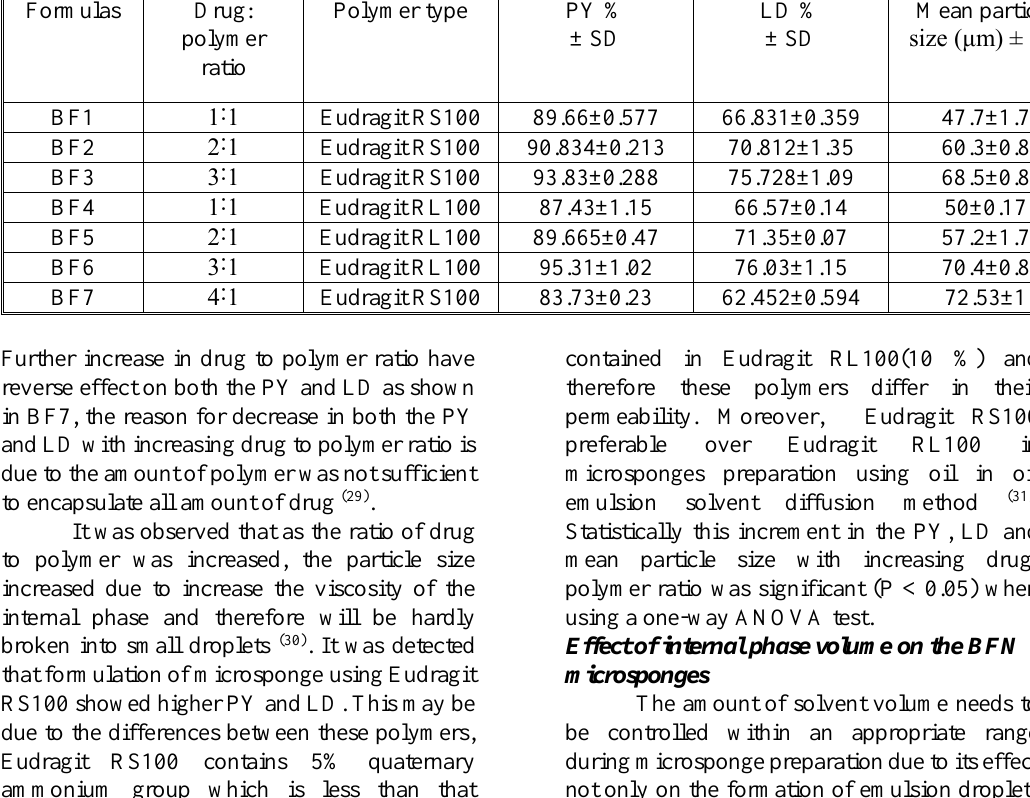
Table (3) Effect of drug: polymer ratio on physical properties of the microsponge